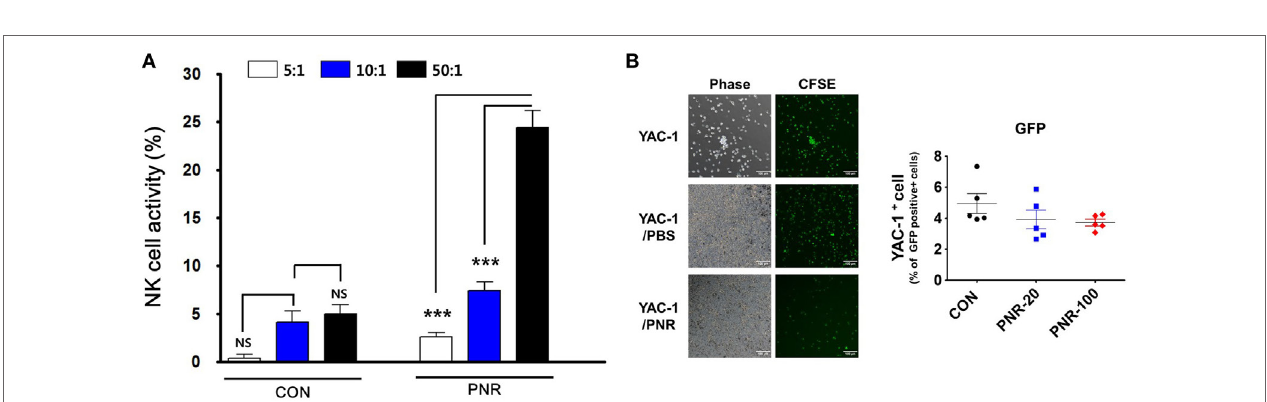
FigUre 9 | Natural killer (NK) cell activity in the splenocytes of mice administered Panax notoginseng root (PNR, 100 mg/kg) water extract. Splenocytes from PNR or phosphate-buffered saline (PBS)-administered mice (CON) were incubated with YAC-1 cells, and the released lactate dehydrogenase (LDH) content